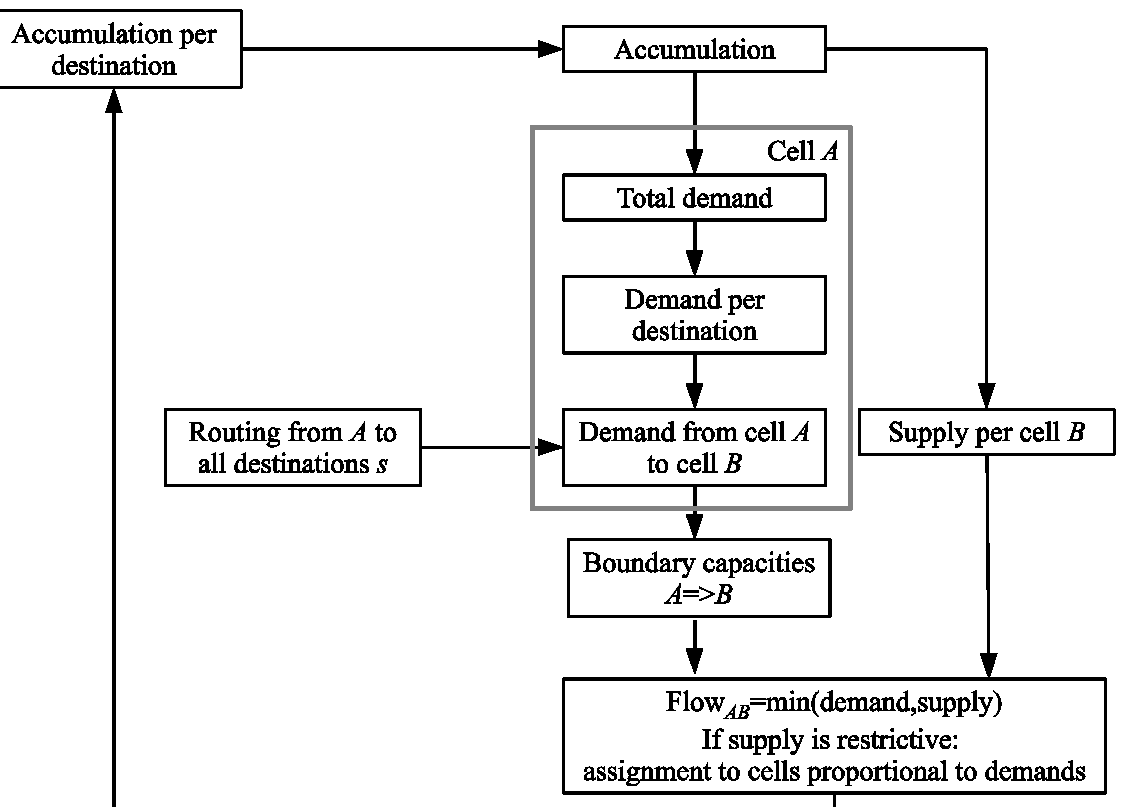
Figure 1. A graphical representation of the steps taken in the computation scheme. The demands are considered for vehicles wanting to leave A, and the supply is calculated for the receiving (neighbouring) cell B, leading to a flow from A to B.